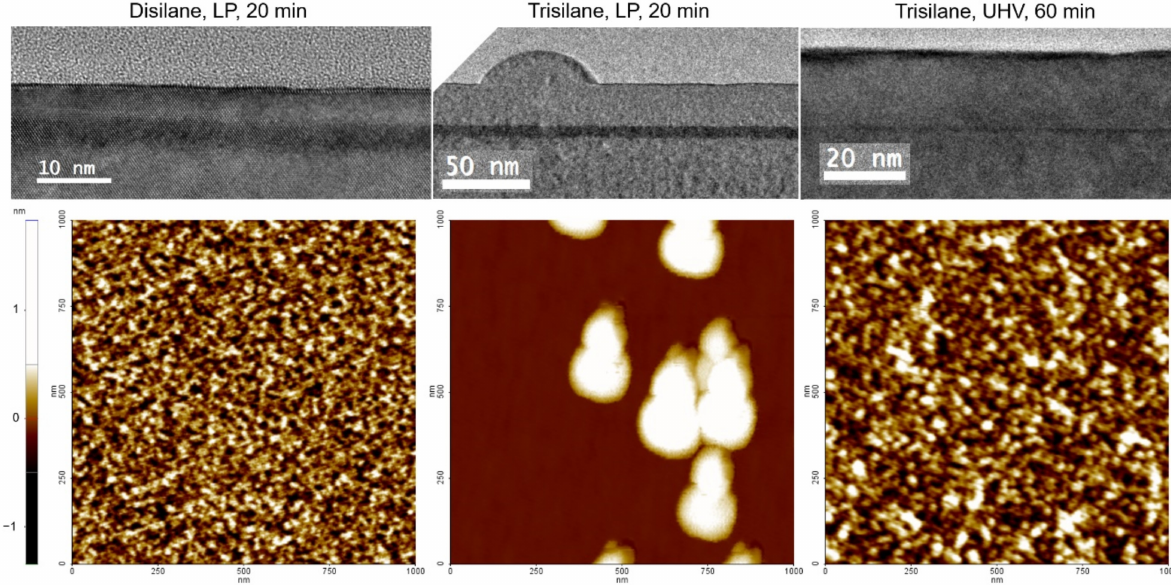
Figure 5. Si epilayers grown at 500 ◦ C using disilane and trisilane under LPCVD and UHVCVD conditions. Islands appear only in trisilane under the LPCVD